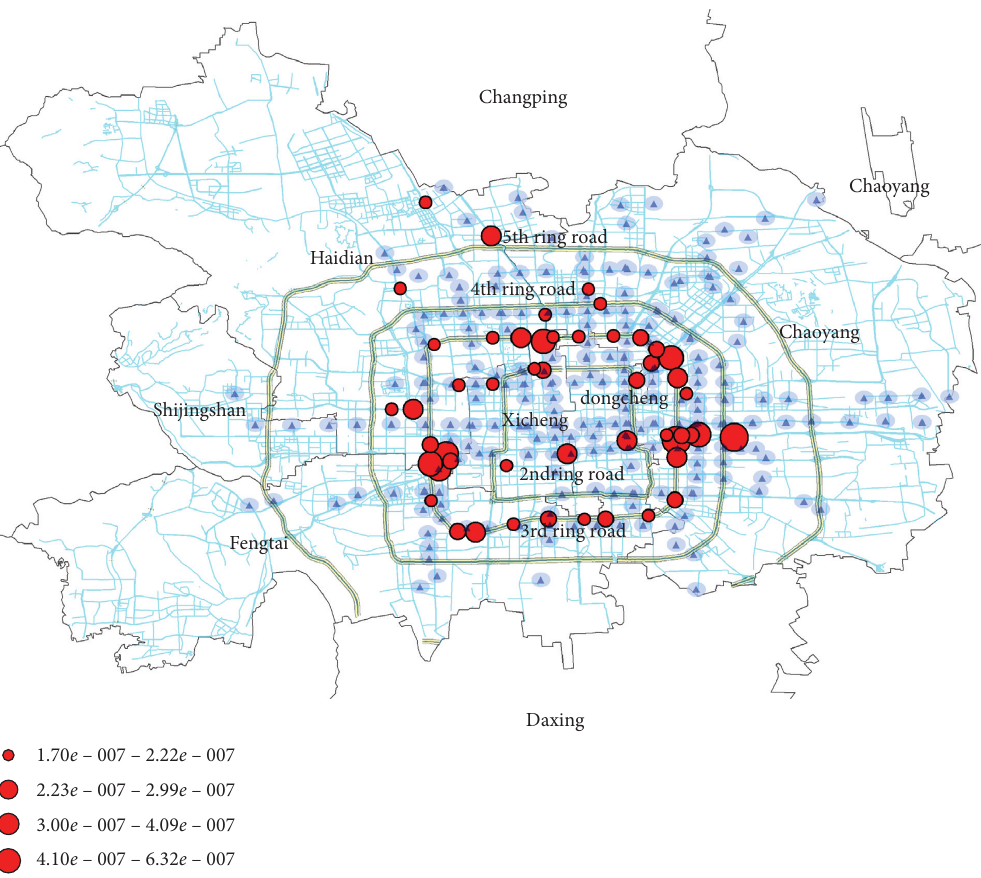
Figure 12: Key bus stations occupying the top 50 in the morning peak (working